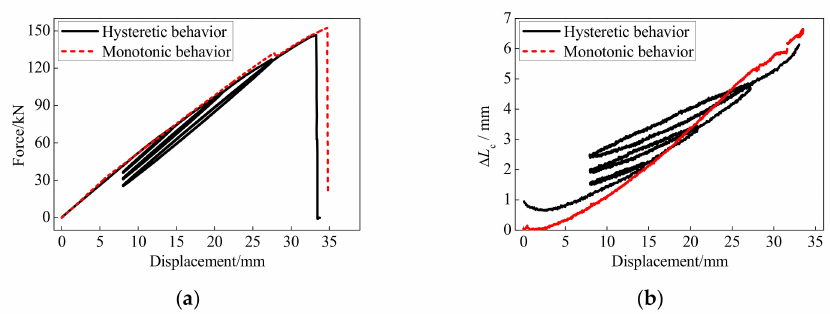
Figure 13. Comparison between the monotonic and hysteretic behaviors: ( a ) force-displacement curve; ( b ) anchor colloidal deformation.